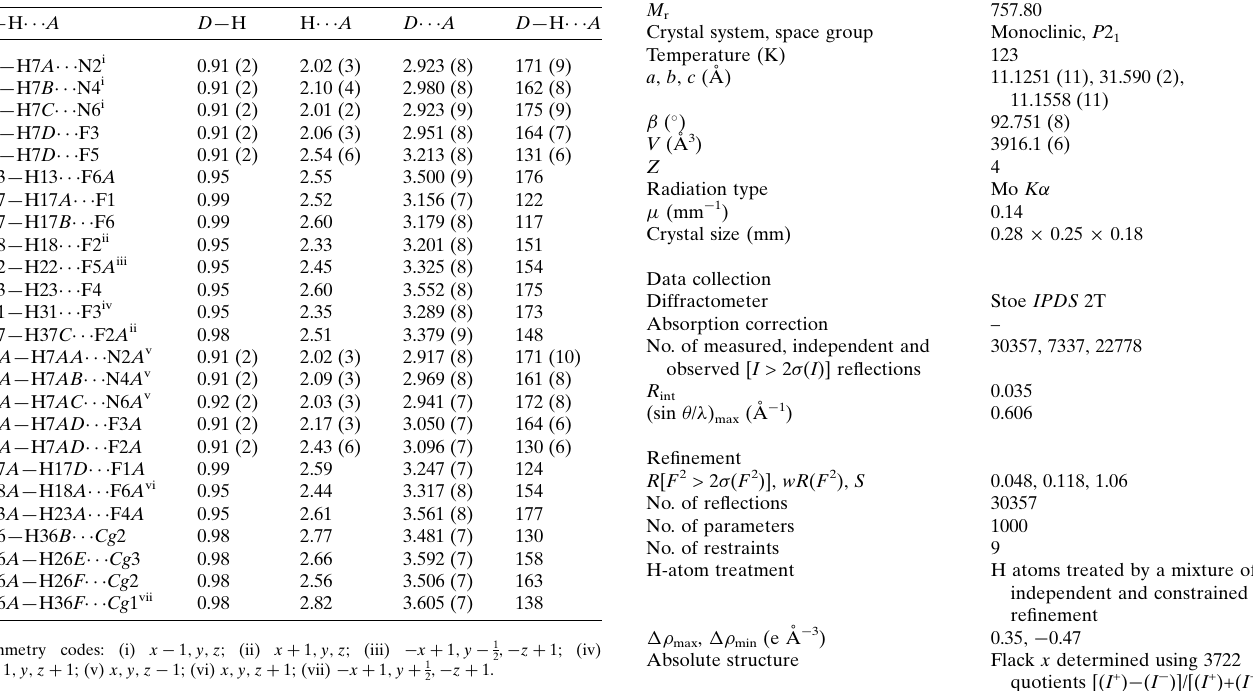
Table 1 Hydrogen-bond geometry (A˚ , (cid:4) ). Cg 1, Cg 2 and Cg 3 represent the centroids of the N3/N4/C18/C19/C24, N3 A / N4 A /C18 A /C19 A /C24 A and N5 A /N6 A /C28 A /C29 A /C34 A rings,